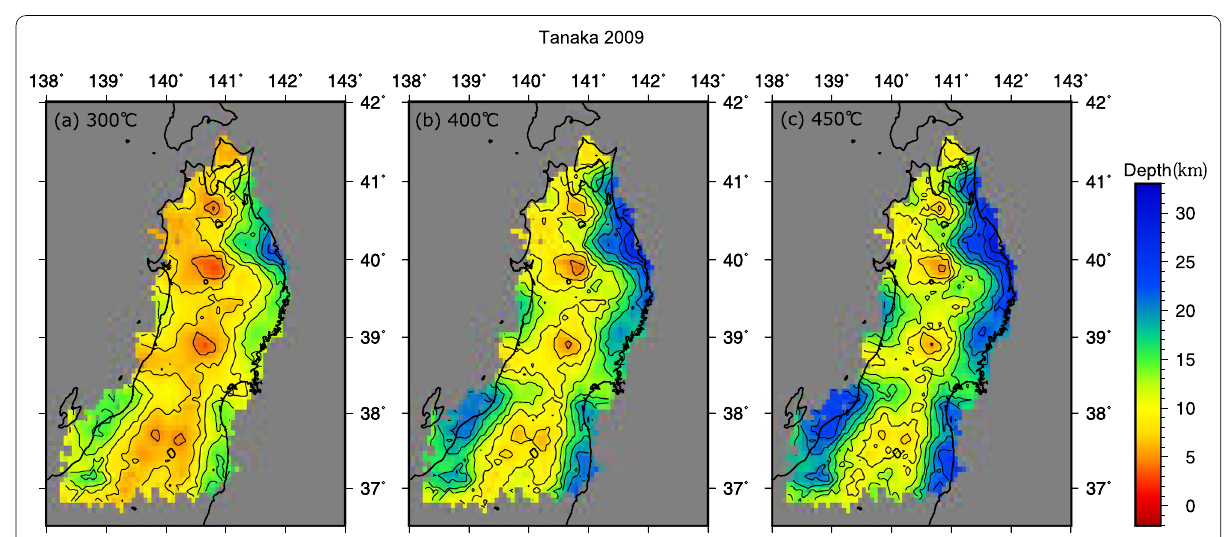
Fig. 14 The depth of the 300 ℃ , 400 ℃ , and 450 ℃ (Model A The depth values reaching each temperature obtained at each measurement point are interpolated by averaging filtering based on the nearest neighbor method. The grid size was set to 4 min, and the search area to 50 km. Based on the values of this grid, isobaths were described at 2.5 km intervals